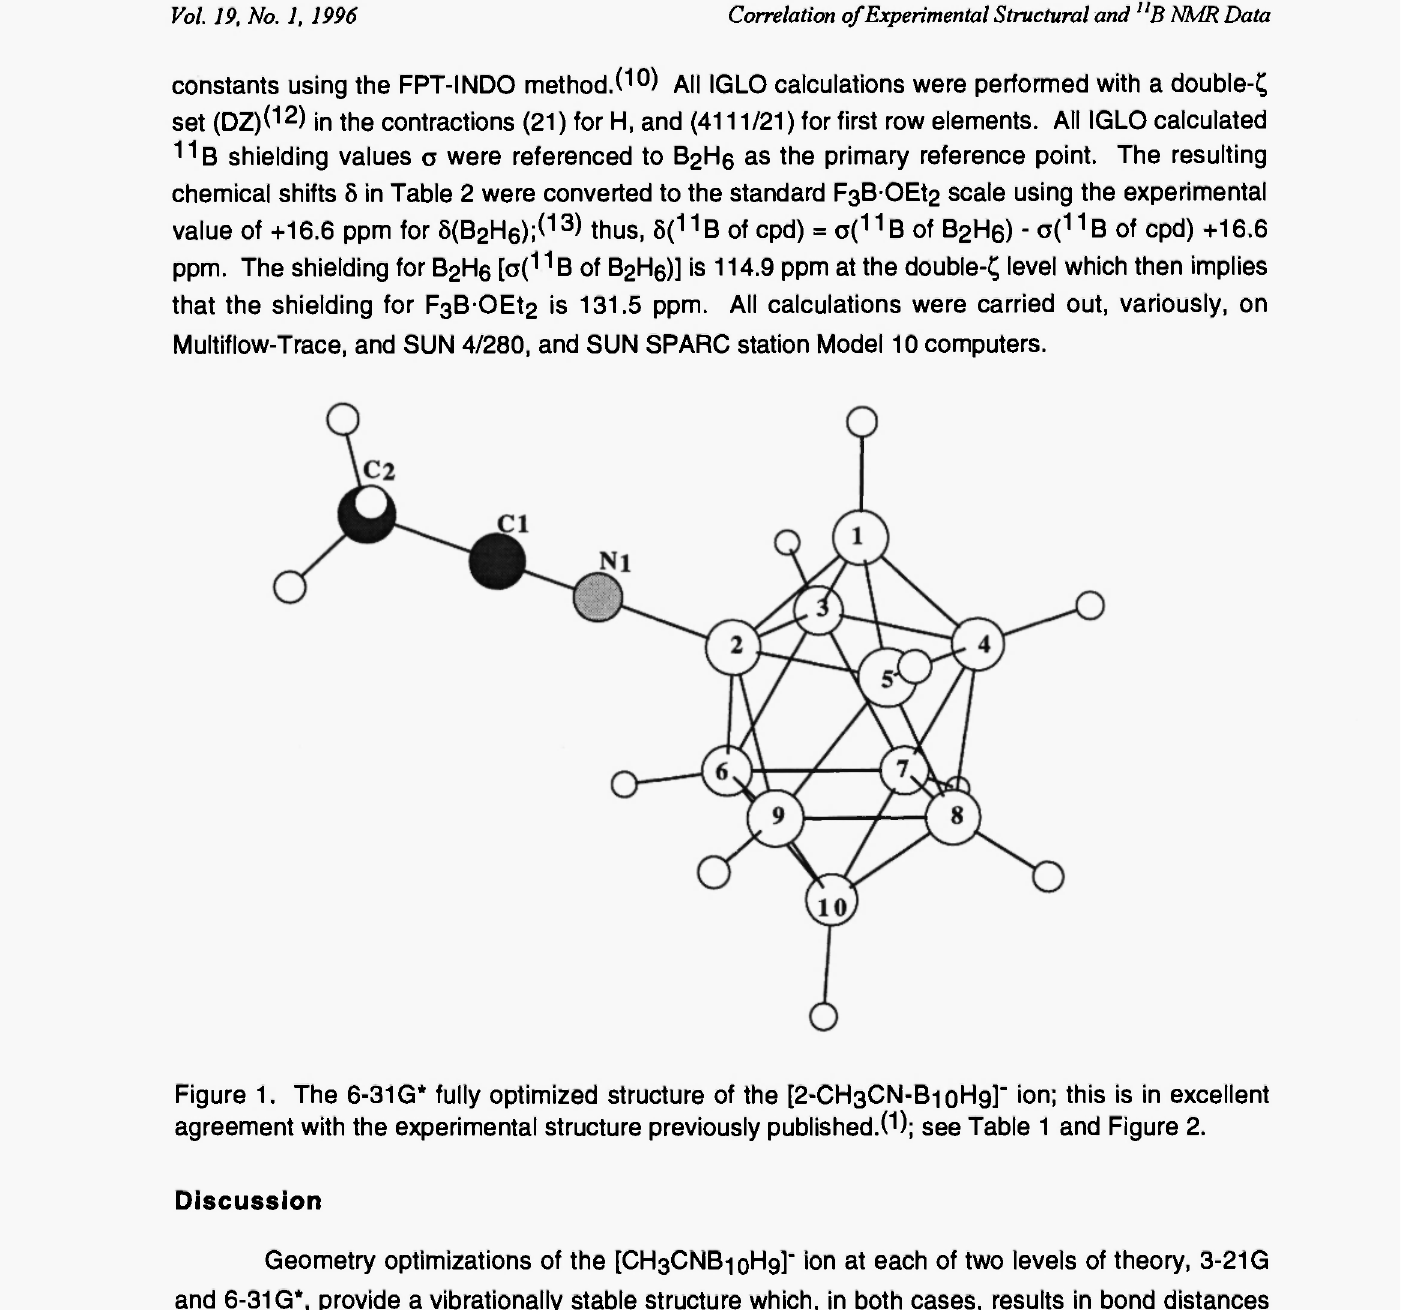
Figure 1. The 6-31G* fully optimized structure of the [2 -CH3CN-B10H9]" ion; this is in excellent agreement with the experimental structure previously published.( 1 ); see Table 1 and Figure